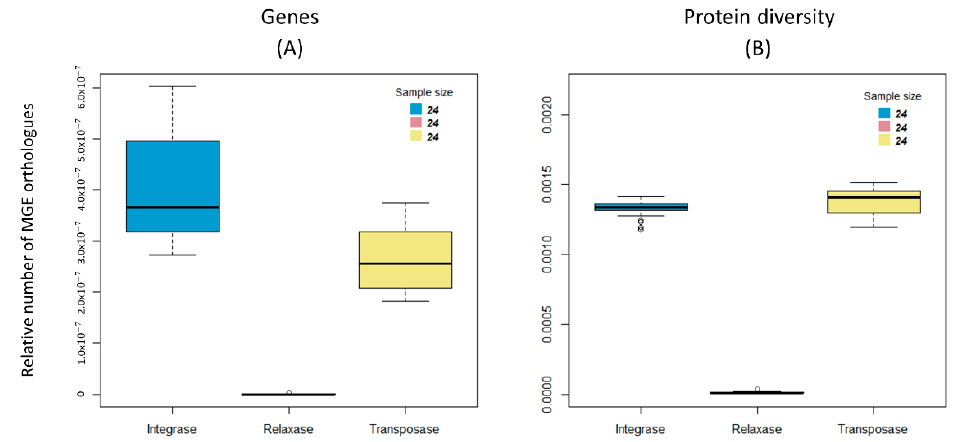
Figure 4. Distribution of the number of orthologues identified by category of mobile genetic elements (MGEs), normalized to metagenome size: ( A ) genes and ( B ) protein diversity. Each boxplot represents a category of MGE, namely integrase (blue), relaxase (pink), and transposase (yellow). All categories of MGE have a sample size of 24. The bottom and top of the boxplot represent the first and third quartiles, while the horizontal line represents the median, and the vertical dashed lines indicate the 1.5 interquartile range. The black circles represent the outliers.